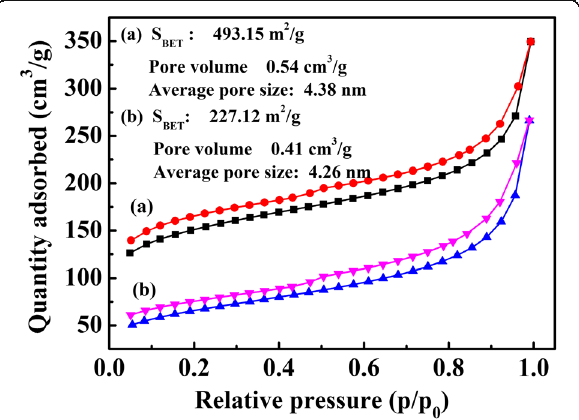
Fig. 5 Nitrogen adsorption – desorption isotherms of (a) TPDB and (b) TPDB-BP-TEA. BET surface areas and pore size distributions of the polymers TPDB and TPDB-BP-TEA were measured by analyzing N 2 adsorption and desorption isotherms at 77 K. The steep rise in the high P/P 0 region indicates that the material consists of micropores and mesopores. TPDB presents a high BET surface area of 493.15 m 2 /g, pore volume of 0.54 cm 3 /g, and average pore size of 4.38 nm. After the two-step modification, the BET surface area and pore volume decreased to 227.12 m 2 /g and 0.41 cm 3 /g,